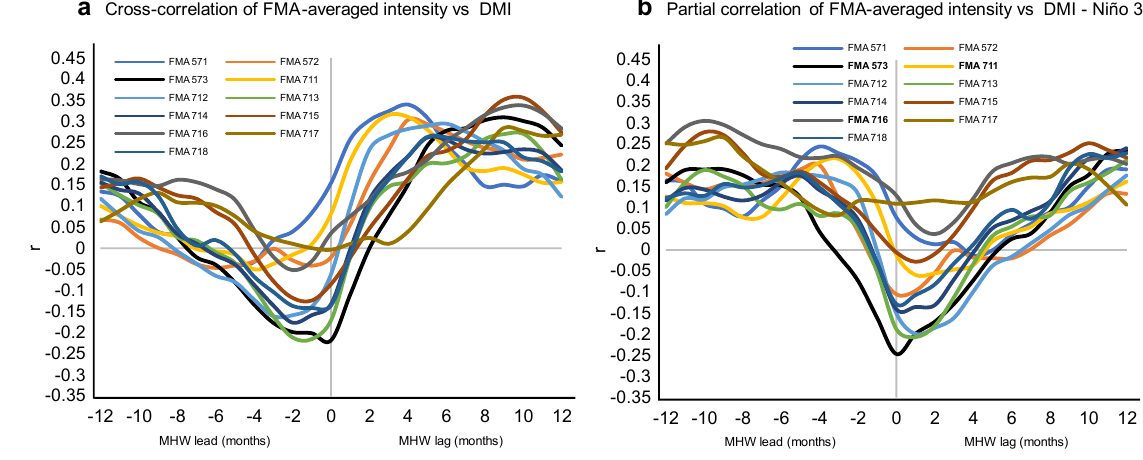
Figure 5. Cross–correlation between DMI– and FMA–averaged MHWs ( a ), partial correlation between Figure 5. Cross – correlation between DMI – and FMA – averaged MHWs ( a ), partial correlation be- J. Mar. Sci. Eng. 2023 , 11 , x FOR PEER REVIEW tween DMI – and FMA – averaged MHWs minus Niño 3.4 ( b ). DMI– and FMA–averaged MHWs minus Niño 3.4 ( b ).